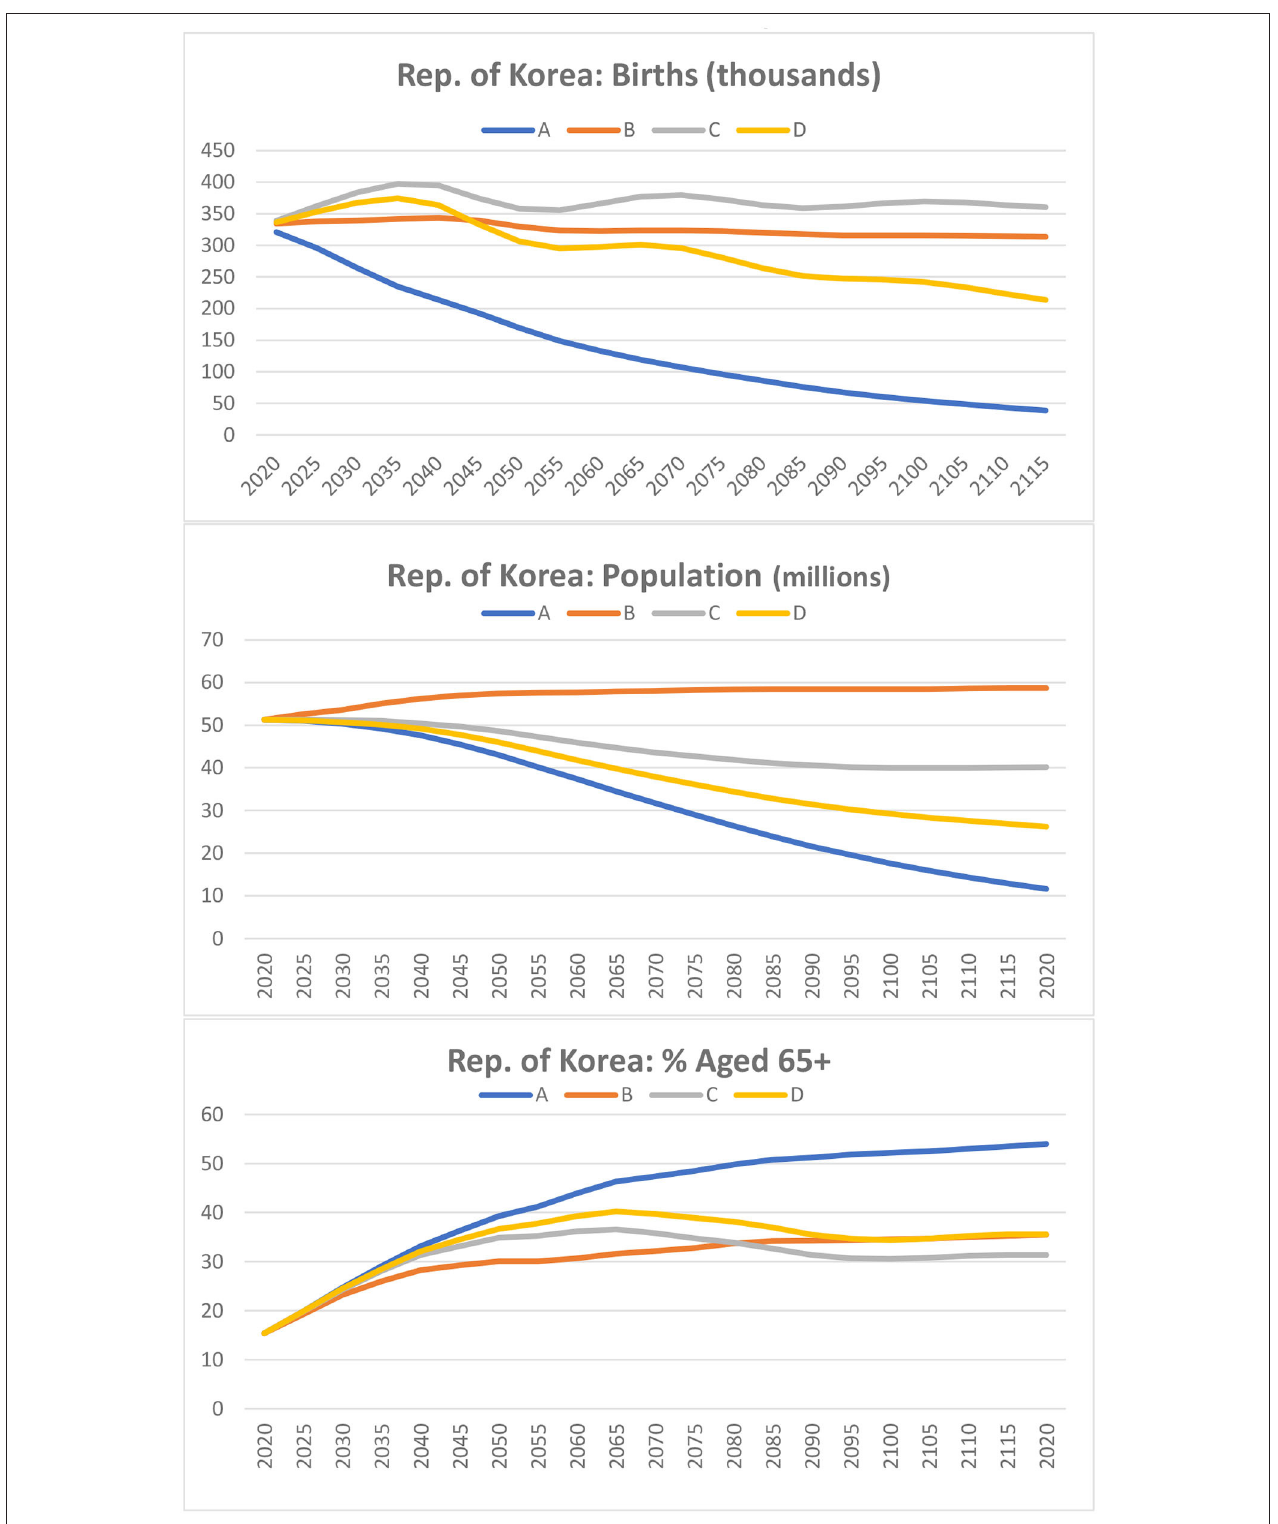
FIGURE 5 | Republic of Korea: Projections of births, population and percent of population aged 65 + . A: TFR = 1.0; Net migration = 0. B: TFR = 1.0; Net migration from 2020 to 2029 = 300,000 and from 2030 onwards = 450,000. C: TFR rises from 1.0 in 2020 to 1.7 in 2040; Net migration, 2020–39 = 50,000, 2040 + = 100,000. D: TFR rises from 1.0 in 2020 to 1.7 in 2040; Net migration = 0.